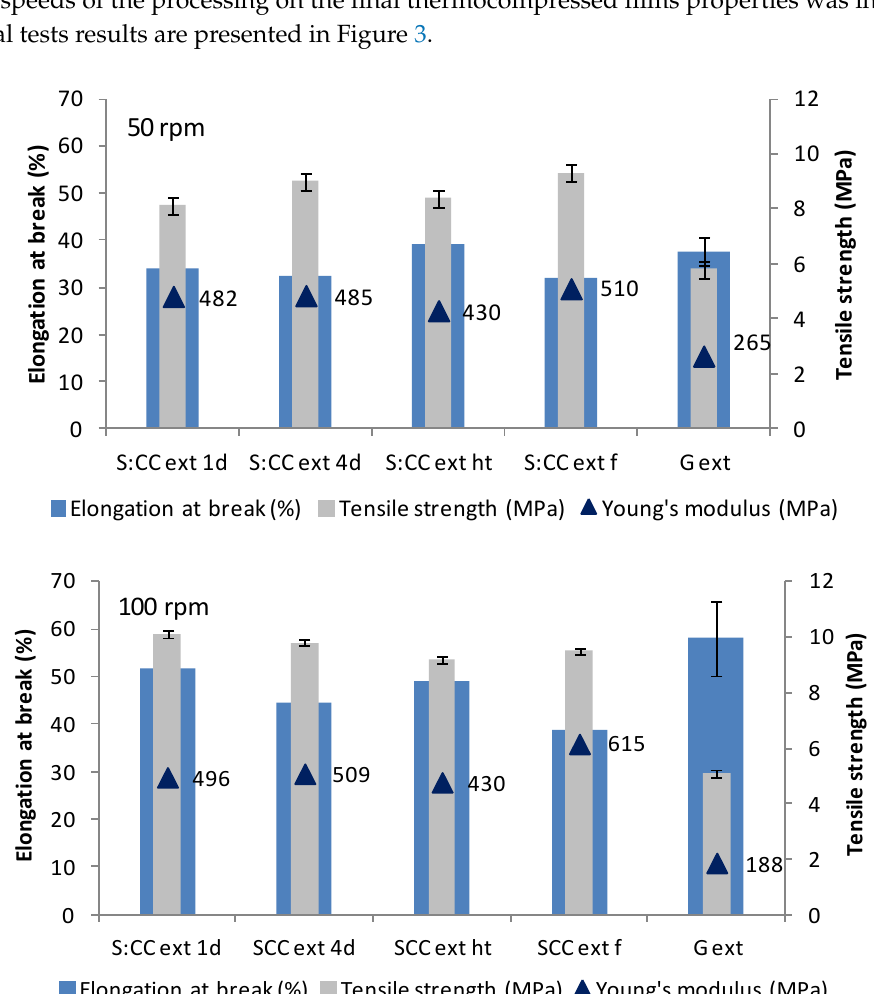
Figure 3. Mechanical properties of TPS / DES films plasticized with S:CC (2:1 molar ratio) prepared from extrudate (at two rotational speed of extrusion) and then thermocompressed.